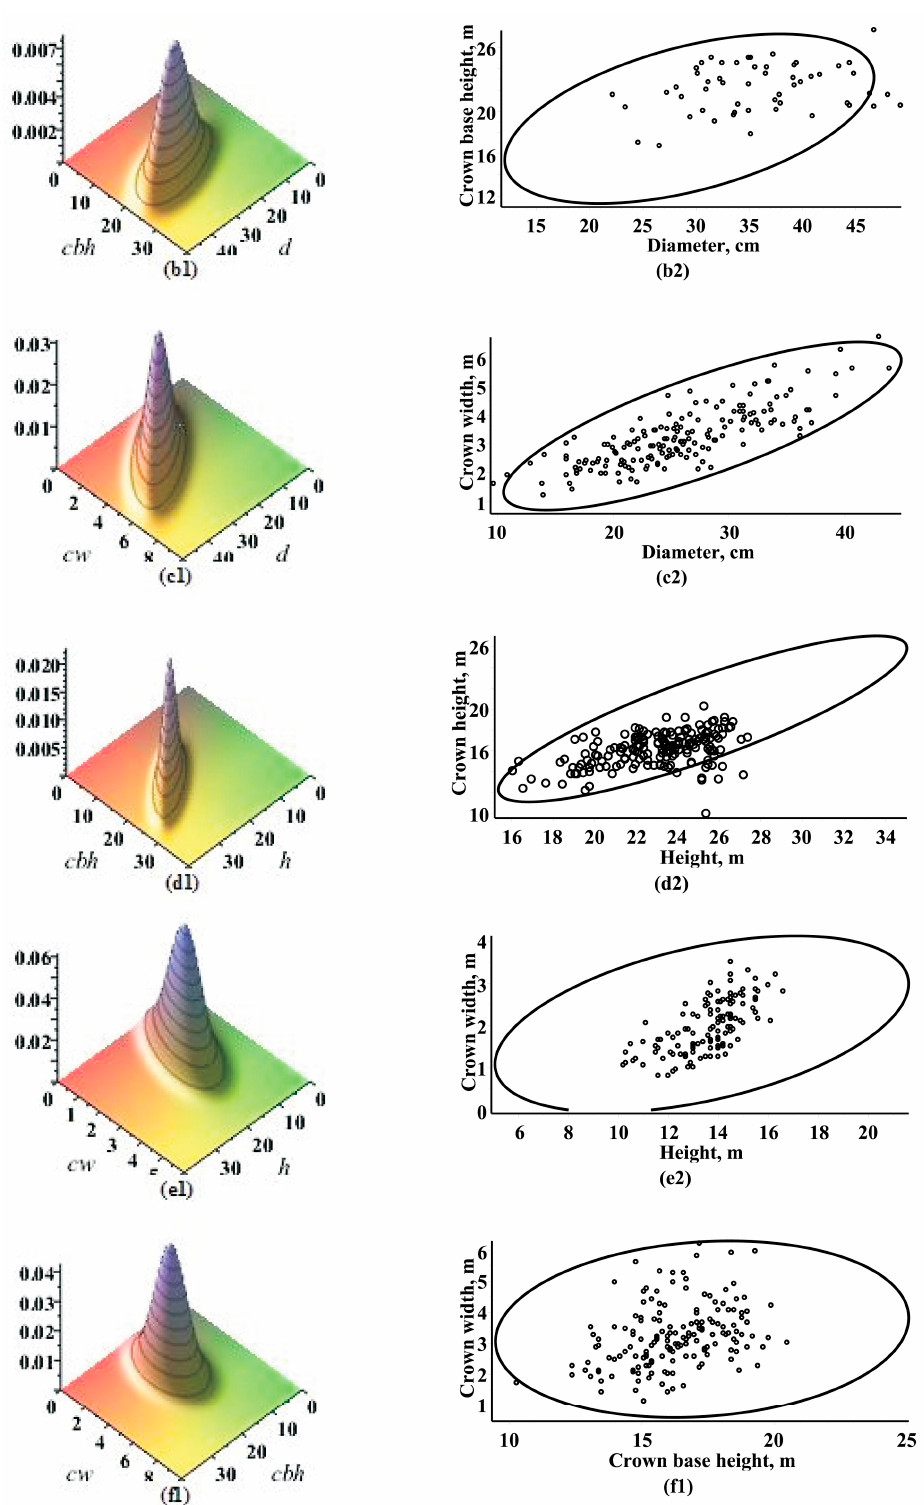
Figure 2. Estimated marginal bivariate density functions and their 95% confidence regions with observed datasets from validation datasets: ( a1 , a2 ) Diameter and height for the first stand; ( b1 , b2 ) Diameter and crown base height for the second stand; ( c1 , c2 ) Diameter and crown width for the third stand; ( d1 , d2 ) Height and crown base height for the fourth stand; ( e1 , e2 ) Height and crown width for the fifth stand; ( f1 , f2 ) Crown base height and crown width for the first stand.